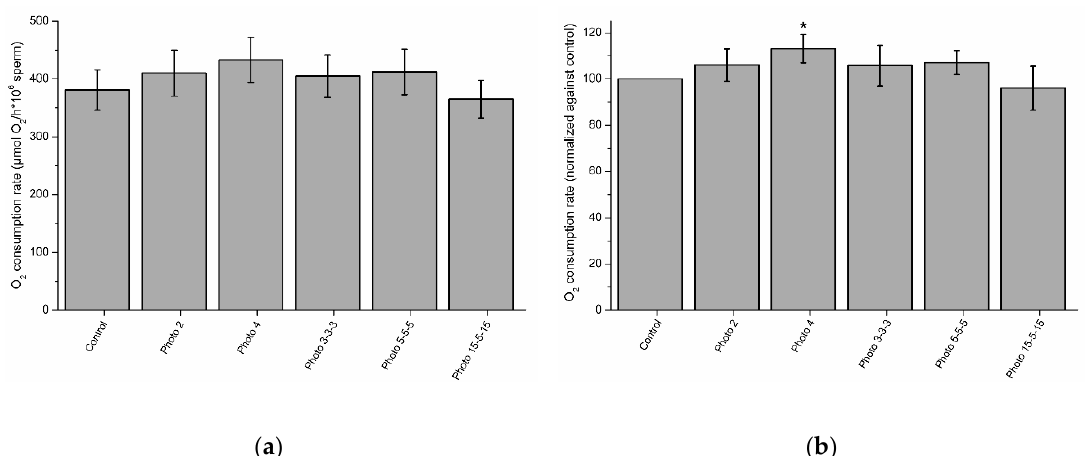
Figure 7. O 2 consumption rates in control and irradiated samples ( a ) , and rates in irradiated samples normalized against the corresponding control ( b ). The superscript (*) means significant differences ( p ≤ 0.05) between the control and irradiation patterns. Data are shown as mean ± SEM of nine independent experiments.